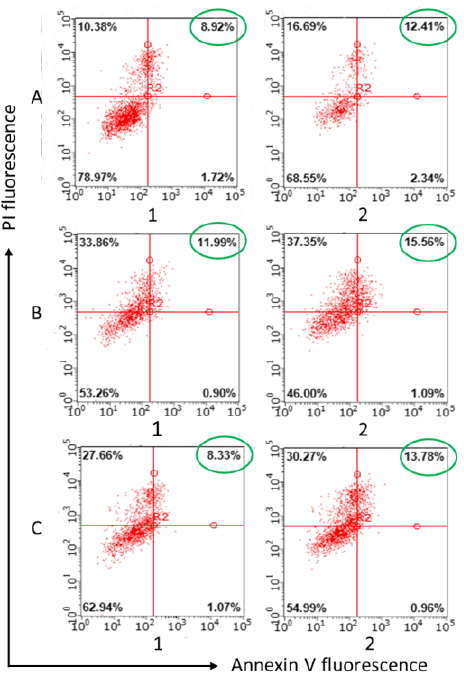
Figure 4. Apoptotic effects measured by flow cytometry using annexin V Alexa Fluor 647 staining protocol. Nanoparticle composition is as follows: ( A ) paclitaxel (PTX); ( B ) CFL 1 mM PC 1 mM PTX 0.08 mM; ( C ) CFL 1 mM PC 1 mM 14-6-14(Et) 0.057 mM and PTX 0.08 mM. Samples were diluted and tested at 0.1 mM of CFL16 (column 1) and 0.2 mM of CFL16 (column 2) or 4 µ M and 8 µ M for paclitaxel,